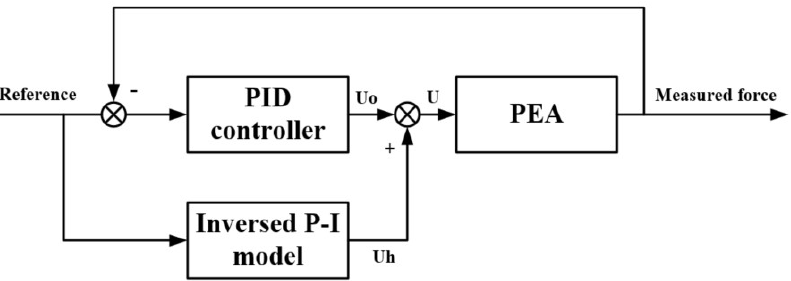
Figure 12. Block diagram of feedforward control and PID control. Figure 13. Step response curve of feedforward control and PID control.